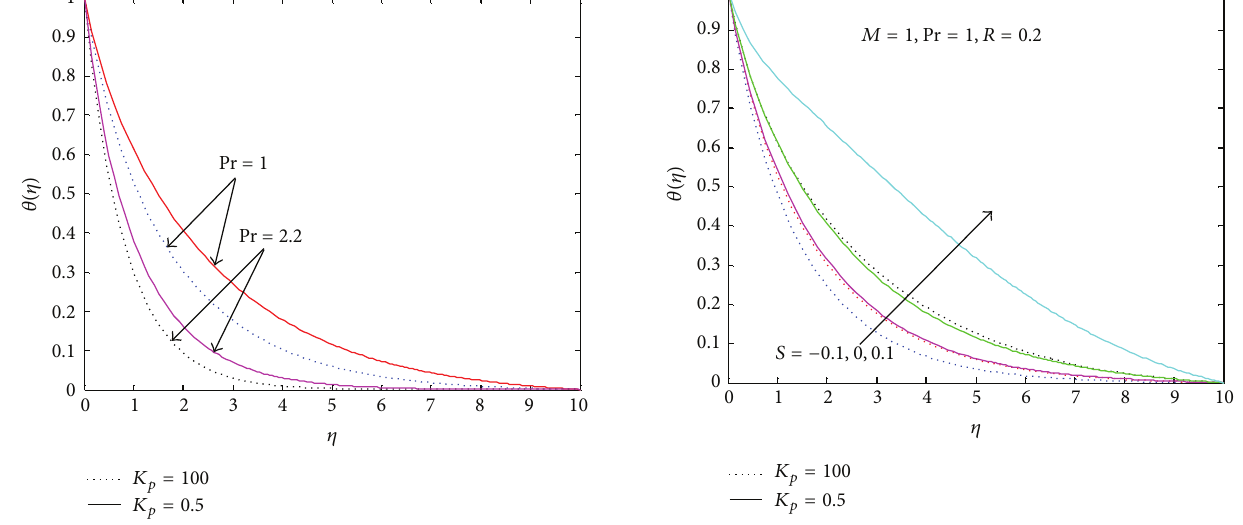
Figure4:TemperaturedistributionfordifferentvaluesofPrand 𝐾 𝑝 .